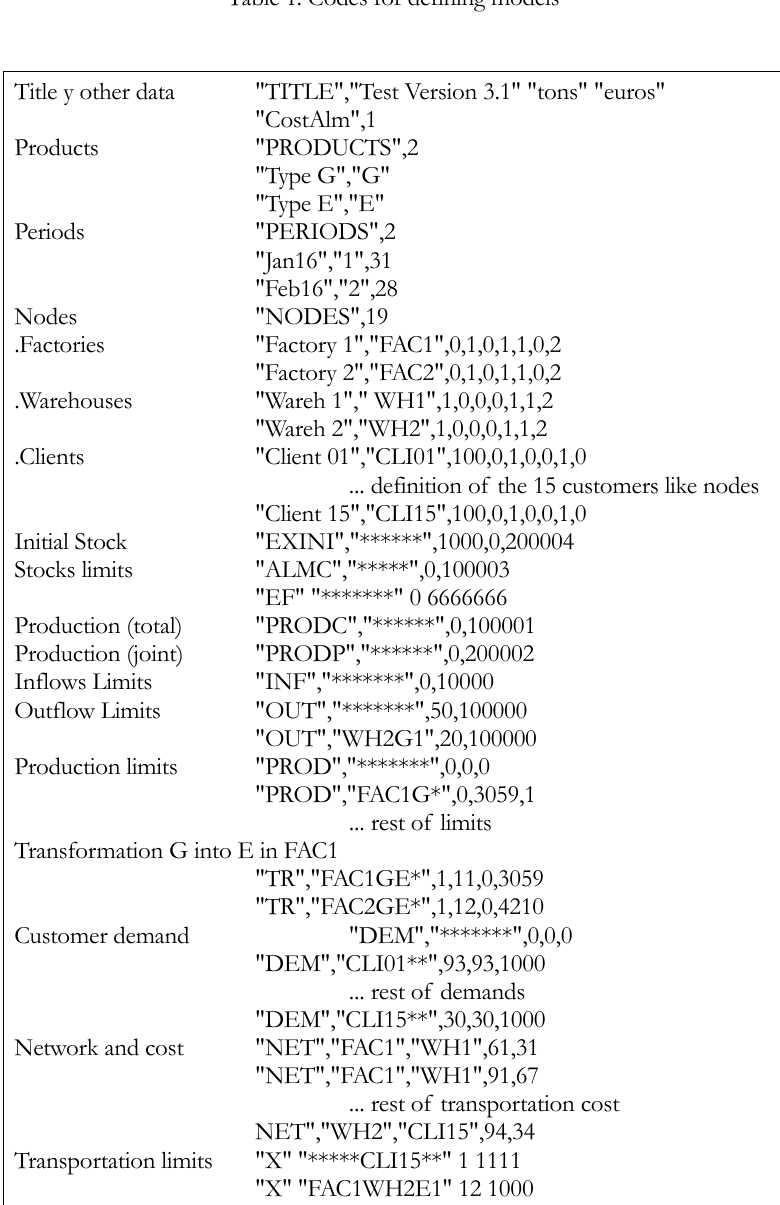
Table 1. Codes for defining models